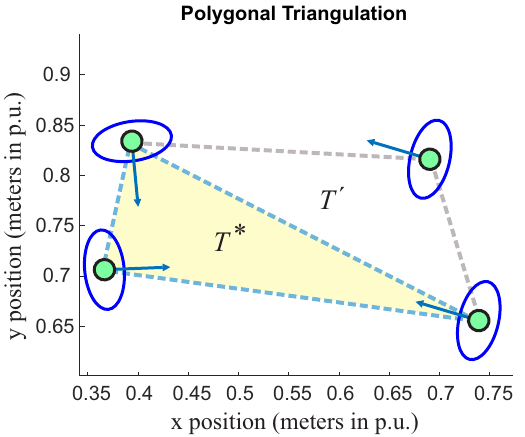
x position (meters in p.u.) Figure 6. Group classification. The yellow triangle is related here to the reference triangle ( T ∗ ) for group classification.